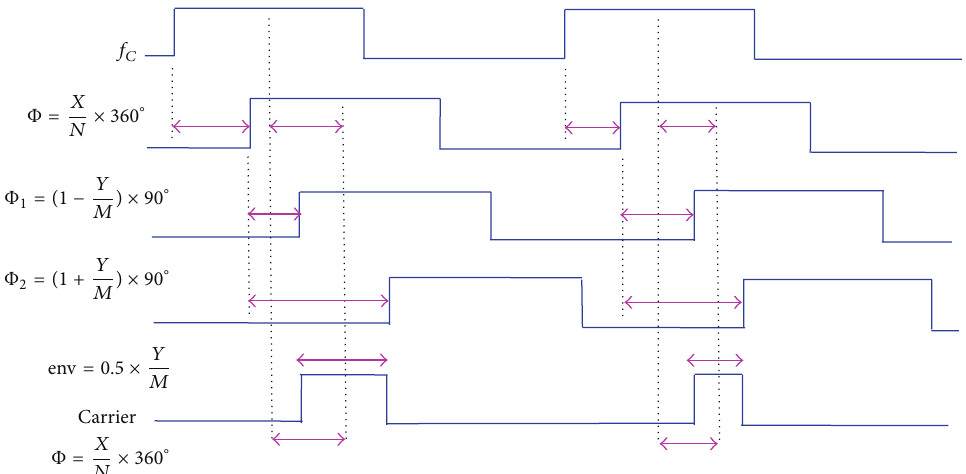
Figure 5: Function diagram of proposed CF-PWM